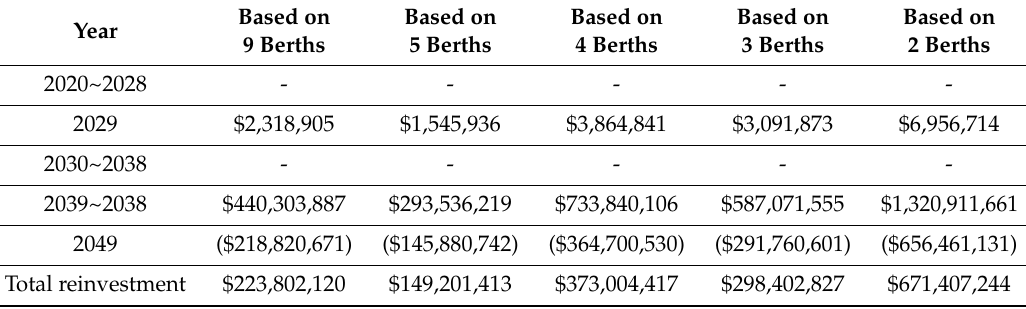
Table 7. Reinvestment and residual value (unit: U.S. Dollars).